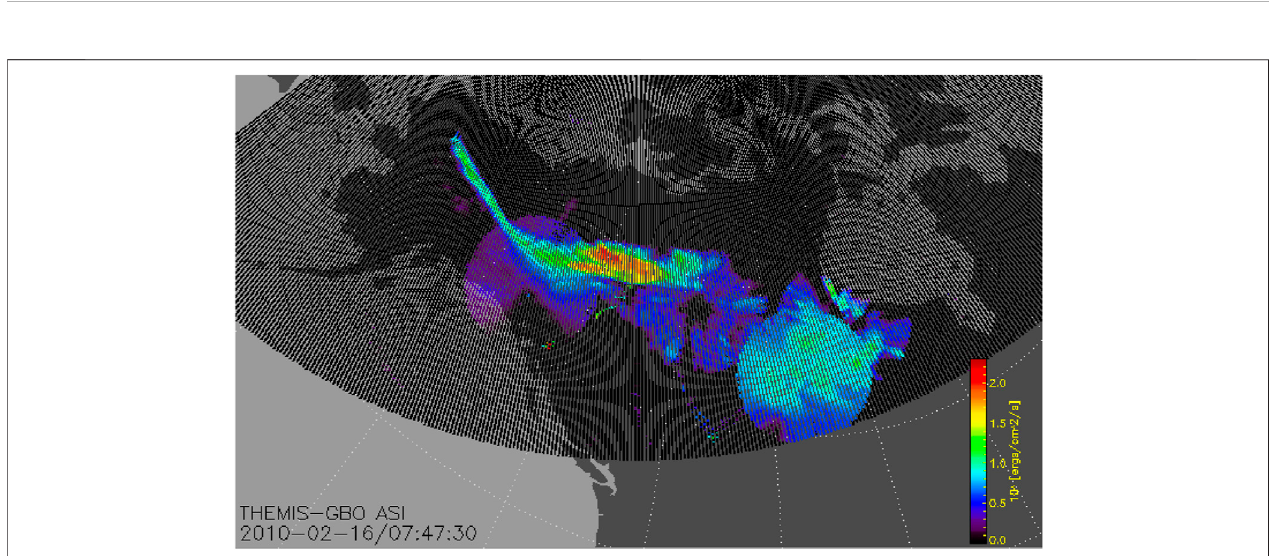
FIGURE 5 | Example of the energy fl ux saved into the 400 × 400 grid. Note that the plot energy fl ux (color) is in log space, with energy fl uxes ranging from 1 – 200 ergs cm − 2 s − 1 ).